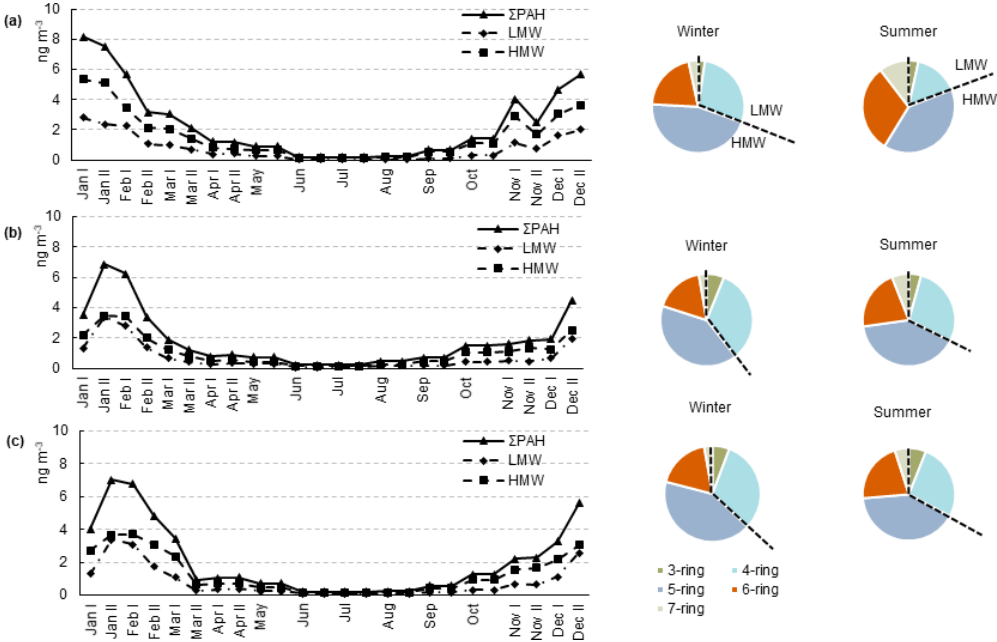
Figure 3. Seasonal variation of low and high molecular weight PAHs in PM 10 collected from three sampling sites in 2017: (a) DE, (b) EN and (c)